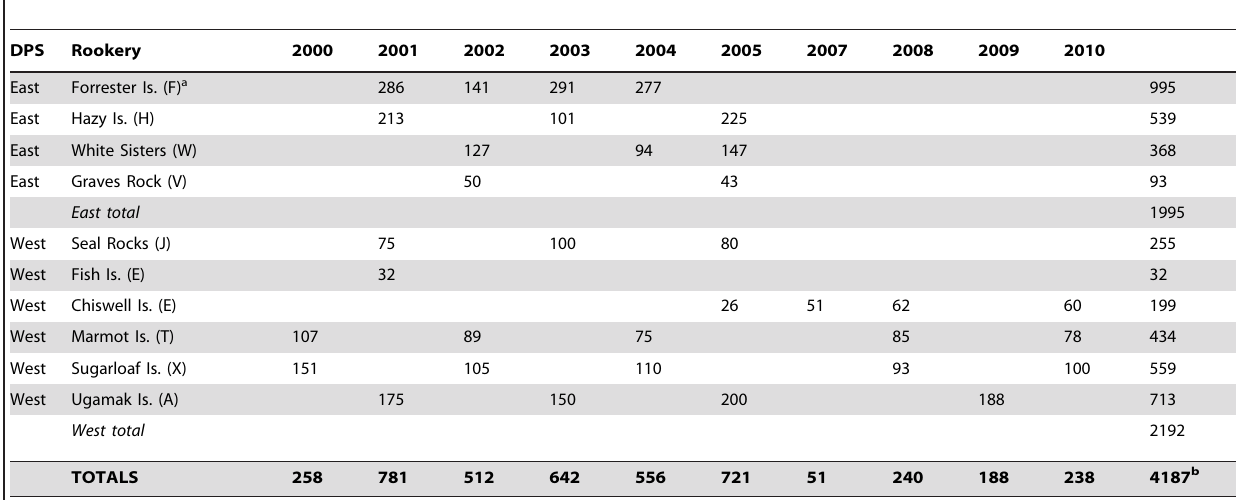
Table 1. Number of Steller sea lions branded as pups at their natal rookery in the eastern and western DPS within Alaska, 2000– 2010.